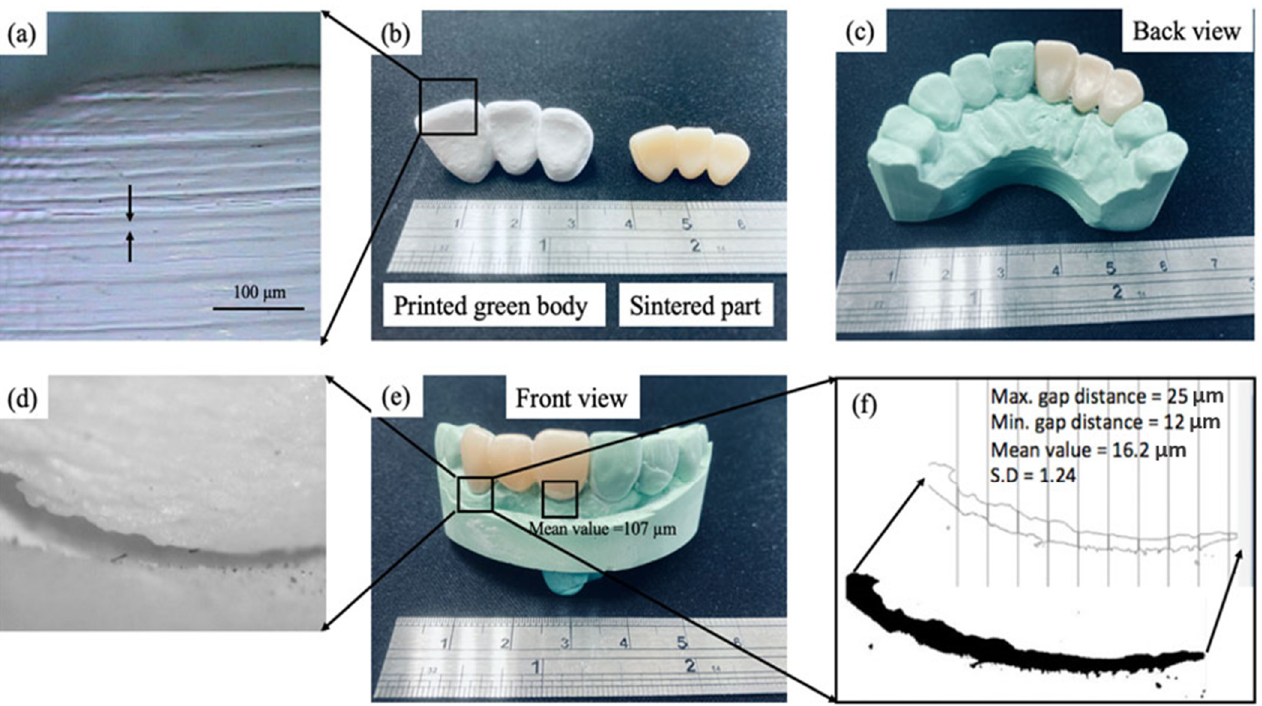
Figure 13. ( a – f ) The printed green body and the sintered part for the benchmark: micro observations and macro observa- tions.